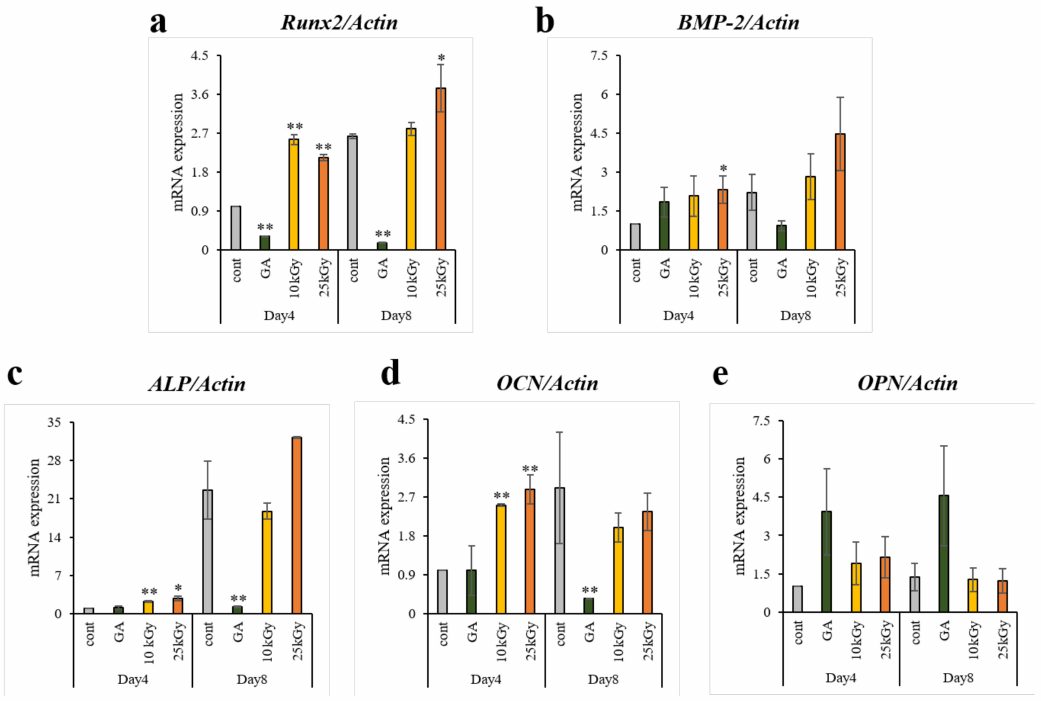
Figure 5. Real-time PCR analysis of hMSCs on titanium surfaces. ( a ) Runx2 , ( b ) BMP-2 , ( c ) ALP , ( d ) OCN and ( e ) OPN were selected as the osteogenic differentiation related genes. Data are mean ± SD. n = 3. The symbol “*” indicates statistical significance compare to control (* p < 0.05, ** p <